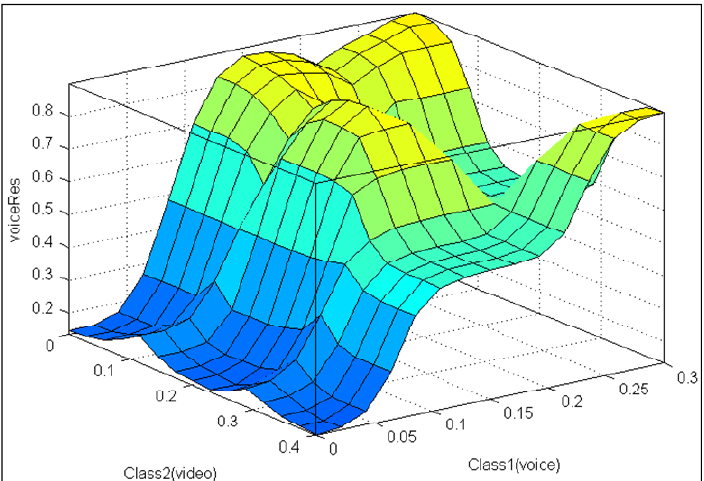
Figure 11. Sample output Resource allocation surface map for Class 1 with varying Class 2 and Class 1 network